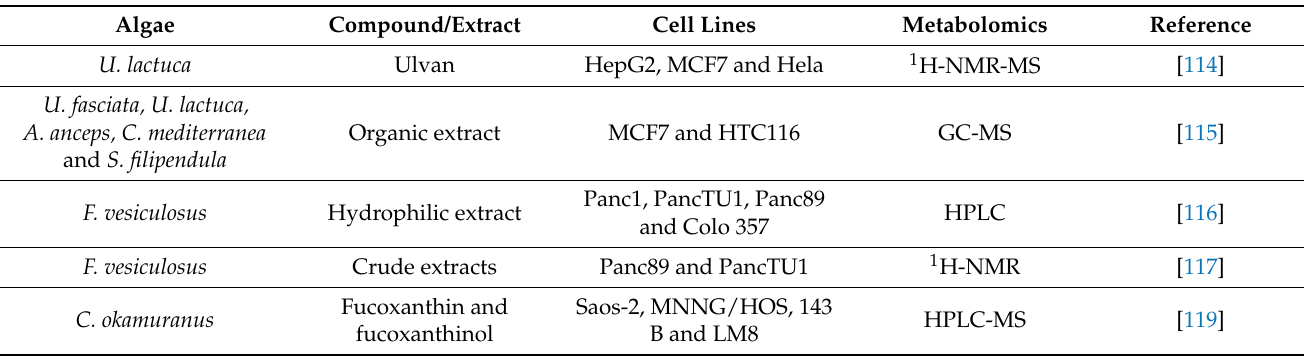
Table 2. Algal species, compound or extract, cell lines tested, metabolomics techniques and corre- sponding reference are